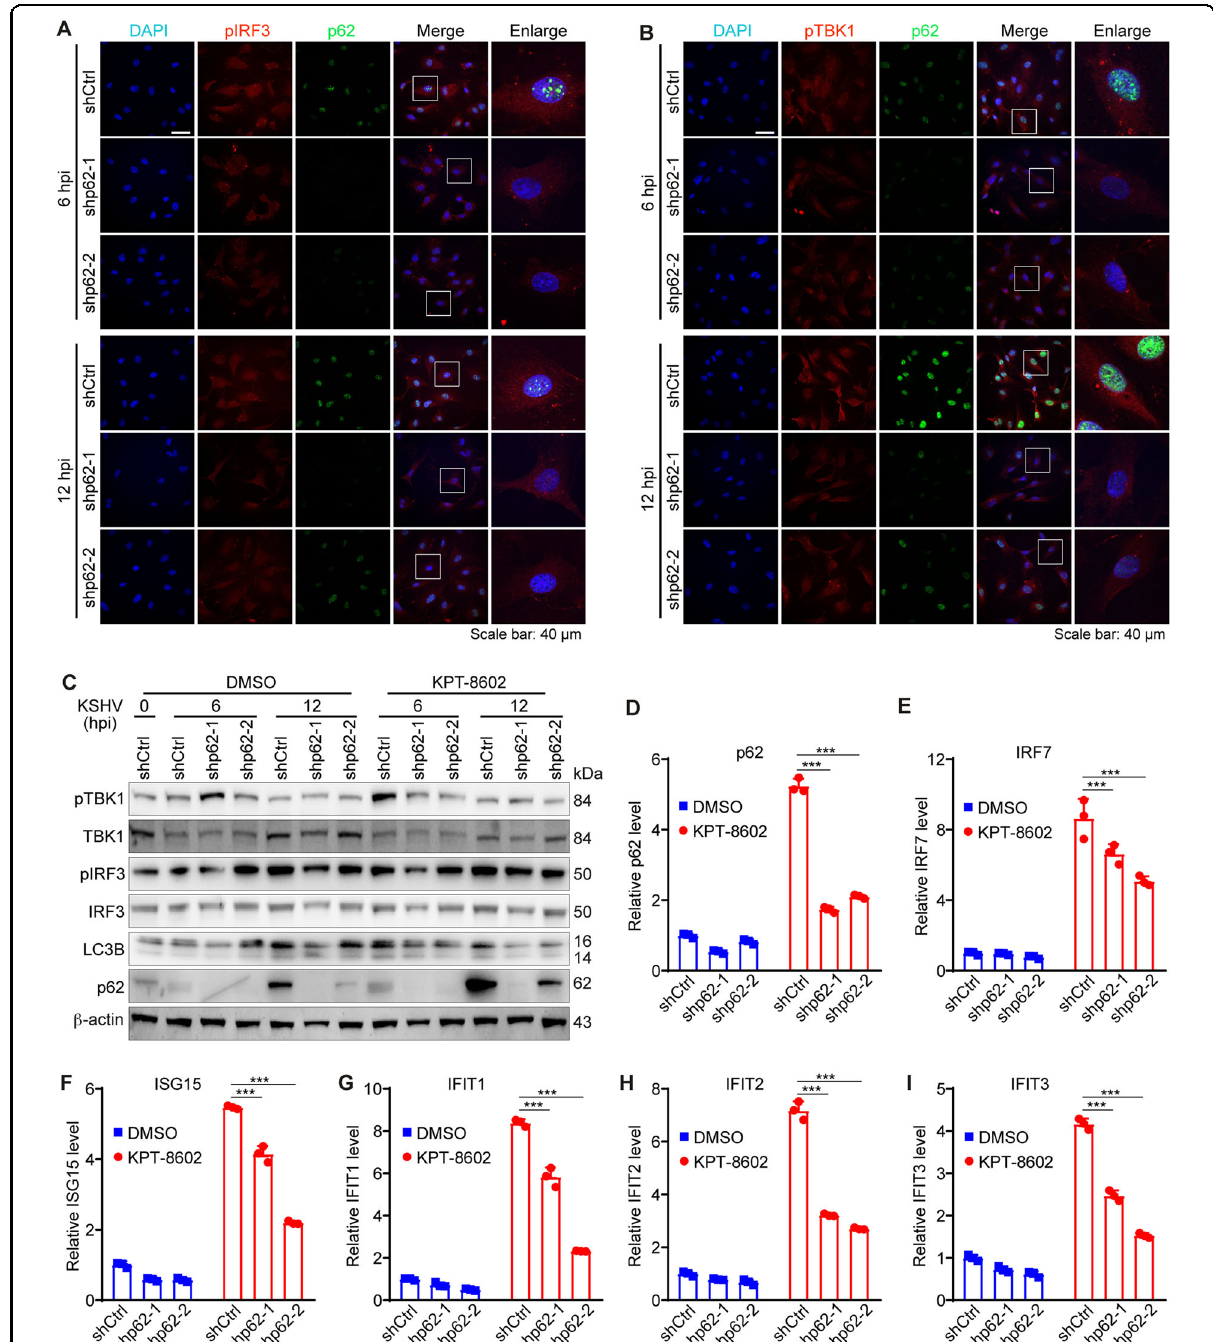
Fig. 8 p62 nuclear retention mediates induction of innate immune responses and inhibits KSHV lytic replication during primary infection. A , B HUVEC with p62 knockdown were pretreated with KPT-8602 at 0.5 µM for 1 h and then infected with KSHV for 6 or 12 h in the presence of